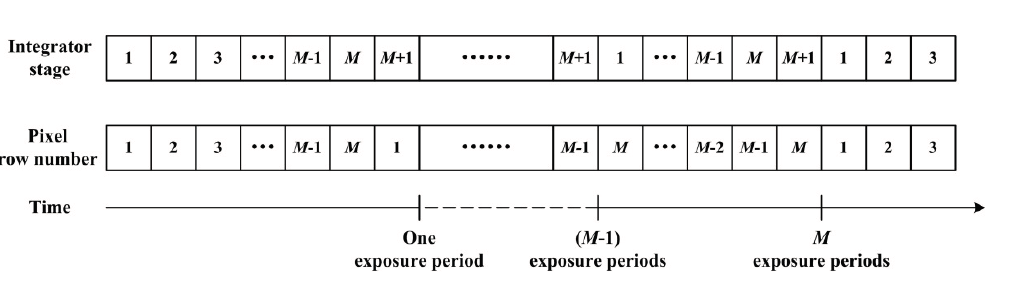
Figure 3. Correspondence between the integrator stage and the pixel row number in the pixel